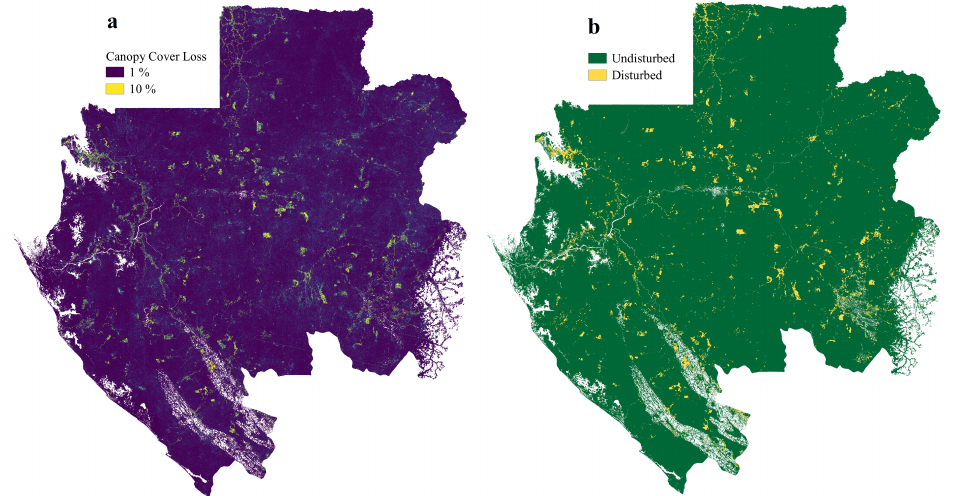
Figure 8. ( a ) Gross canopy cover loss per 1 ha cell across Gabon estimated by Sentinel-1 shadows for the year 2020; ( b ) classification of Gabonese forest into undisturbed (green) and disturbed (yellow) areas, created by considering spatiotemporal patterns of canopy